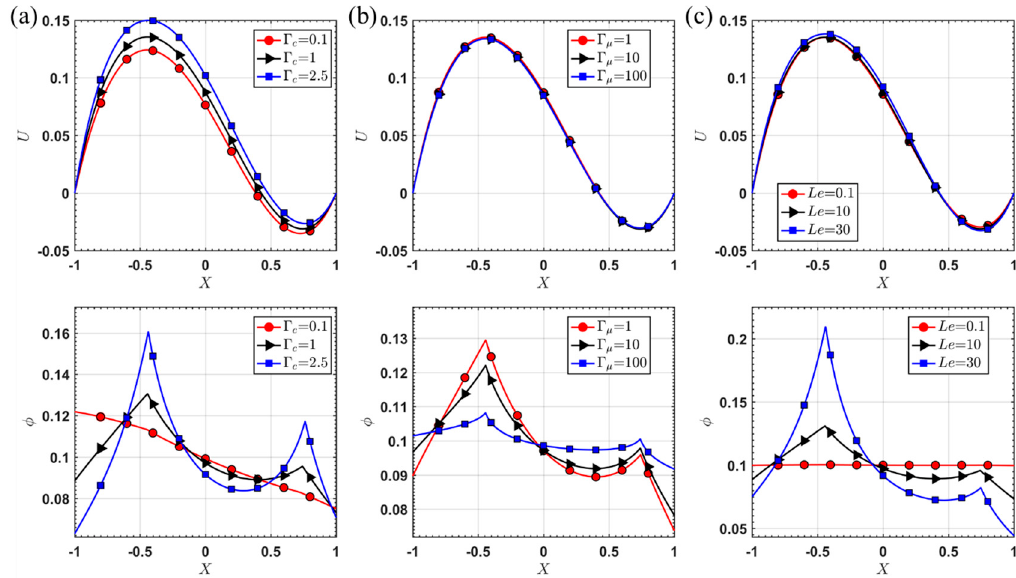
Figure 8. E ff ect of particle fluxes, Γ c , Γ µ and Le . ( a ) E ff ect of Γ c on the velocity and concentration profiles, when Γ µ = 0.1, Γ g = 1, β = 10 , Le = 10, n = − 0.5, δ = 1, Ra = 3, Br = 5 and φ avg = 0.1. ( b ) E ff ect of Γ µ on the velocity and concentration profiles, when Γ c = 1.0, Γ g = 1, β = 10 , Le = 10, n = − 0.5, δ = 1, Ra = 3, Br = 5 and φ avg = 0.1. ( c ) E ff ect of Le on the velocity and concentration profiles, when Γ c = 1.0, Γ µ = 0.1, Γ g = 1, β = 10 , n = − 0.5, δ = 1, Ra = 3, Br = 5 and φ avg = 0.1.